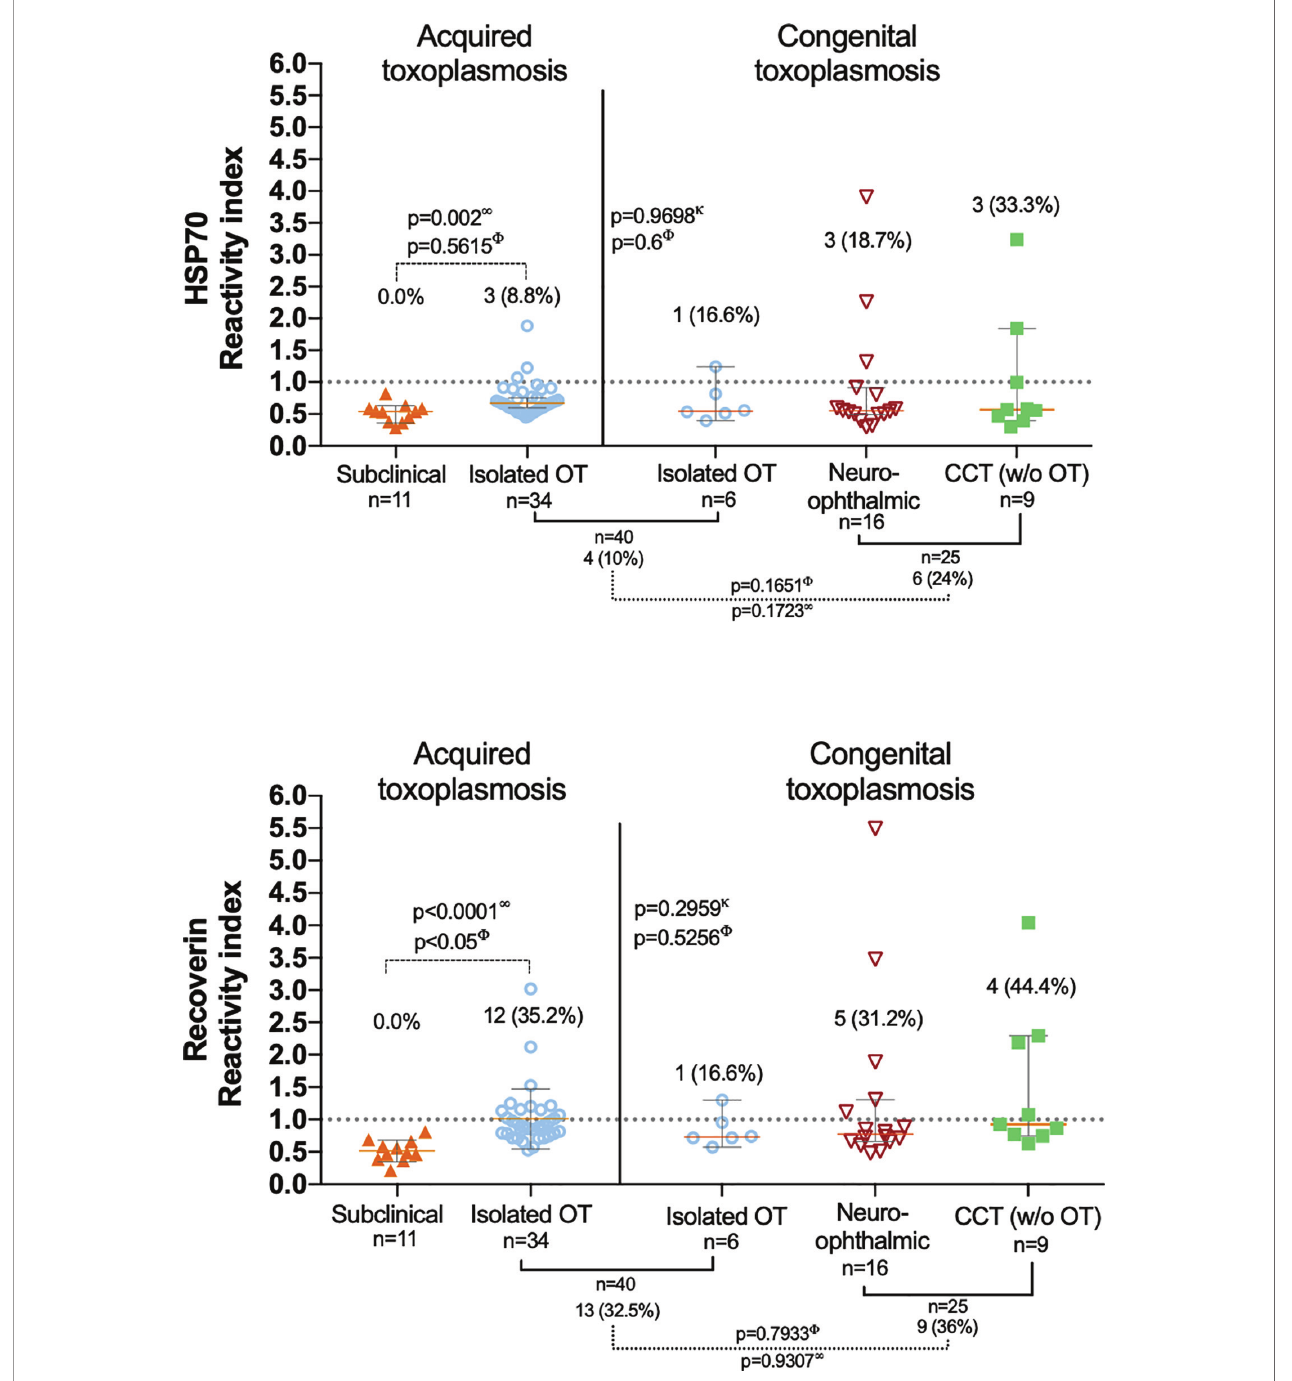
FIGURE 2 | Presence of anti-HSP70 (upper graph) and anti-recoverin (lower graph) autoantibodies in the different clinical groups; the dispersion of the reactivity indices to HSP70 and recoverin is shown, as well as the differences among them (analyzed with ∞ Mann-Whitney U and k Kruskal-Wallis.) and the proportion of positives RI > 1.0 (analyzed with F Fisher ’ s exact test). The only statistically signi fi cant result obtained was the difference between positives in the isolated OT (acquired) and the subclinical